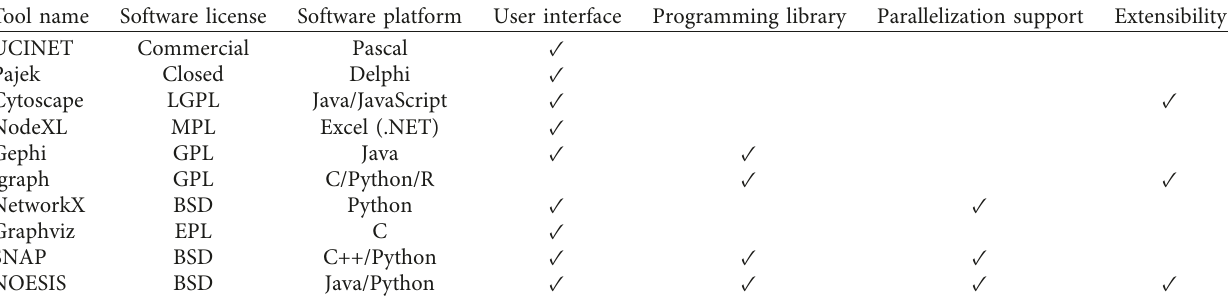
Table 1: Feature comparison of some popular network analysis software packages.